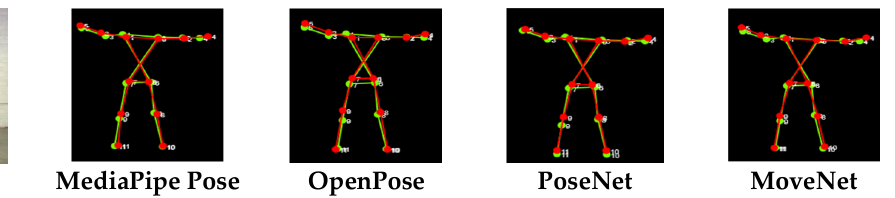
Figure 5. Sample video frame and detection result of Action 8 (jumping jacks). Green lines indicate the ground truth, red lines indicate the tested HPE library.